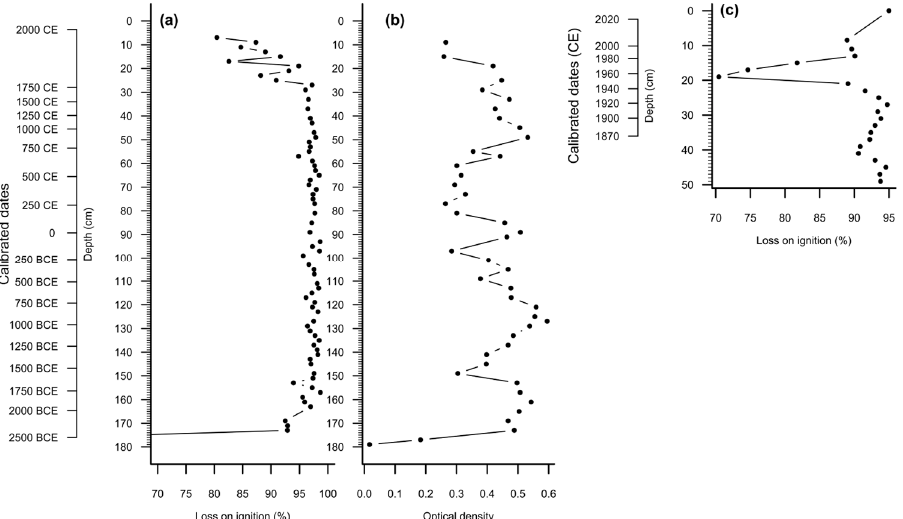
Figure 4. Loss on ignition ( a ) and peat humification as optical density of alkaline extraction ( b ) in the undisturbed peat deposits and loss on ignition in the floating mat deposits ( c ) in the Gorenki mire. BCE—Before Common Era, CE—Common Era.